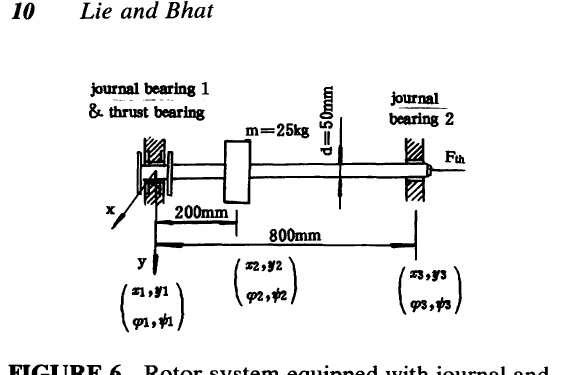
FIGURE 6 Rotor system equipped with journal and thrust bearings.